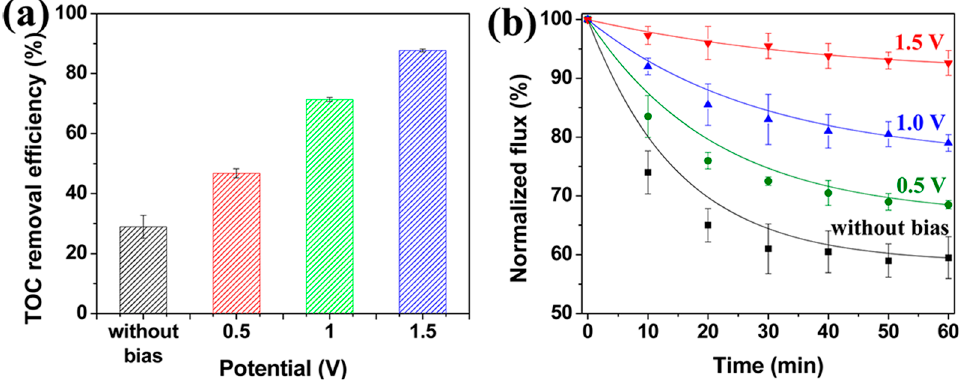
Figure 15. Effect of an applied electrochemical potential on the performance of a MWNT/PAN/Al 2 O 3 membrane exposed to humic acid: ( a ) effect on total organic carbon (TOC) removal efficiency; ( b ) normalised permeate flux. Reprinted with permission from Reference [124]. Copyright American Chemical Society, 2015.